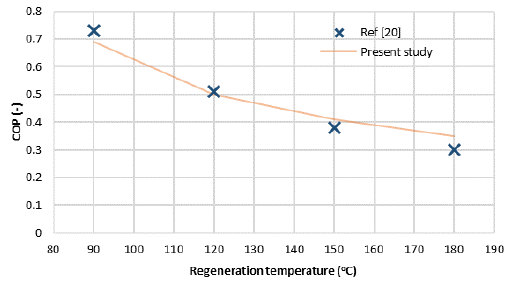
Figure 8. Model verification.